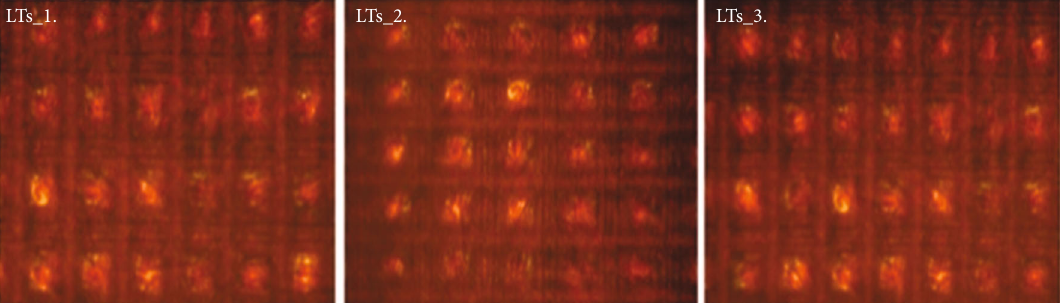
Figure 3: Optical images of laser-textured surfaces.